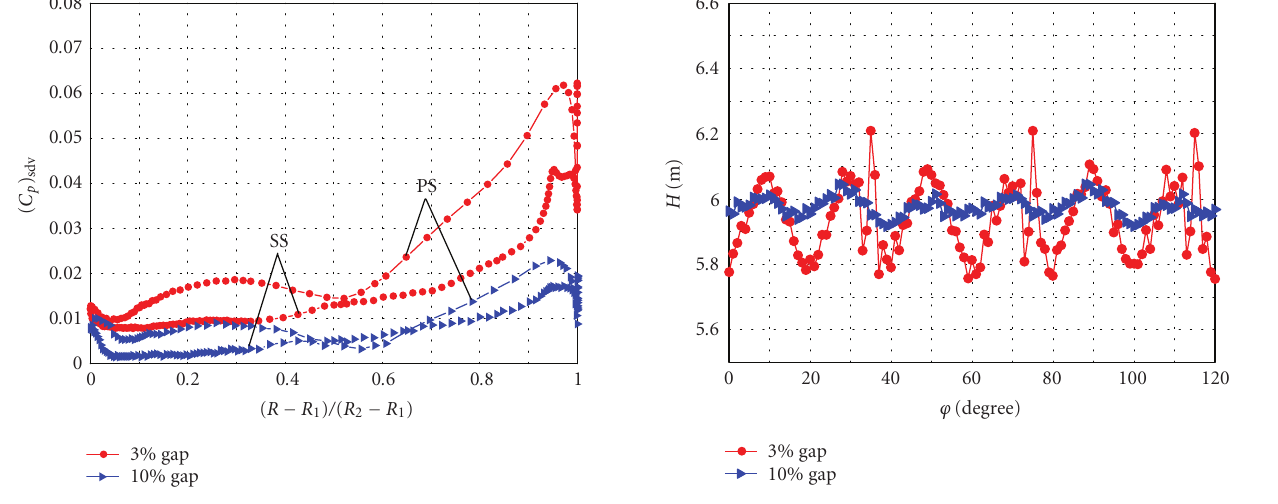
Figure 10: Pressure fluctuations on the impeller blade for two gaps at middle span.